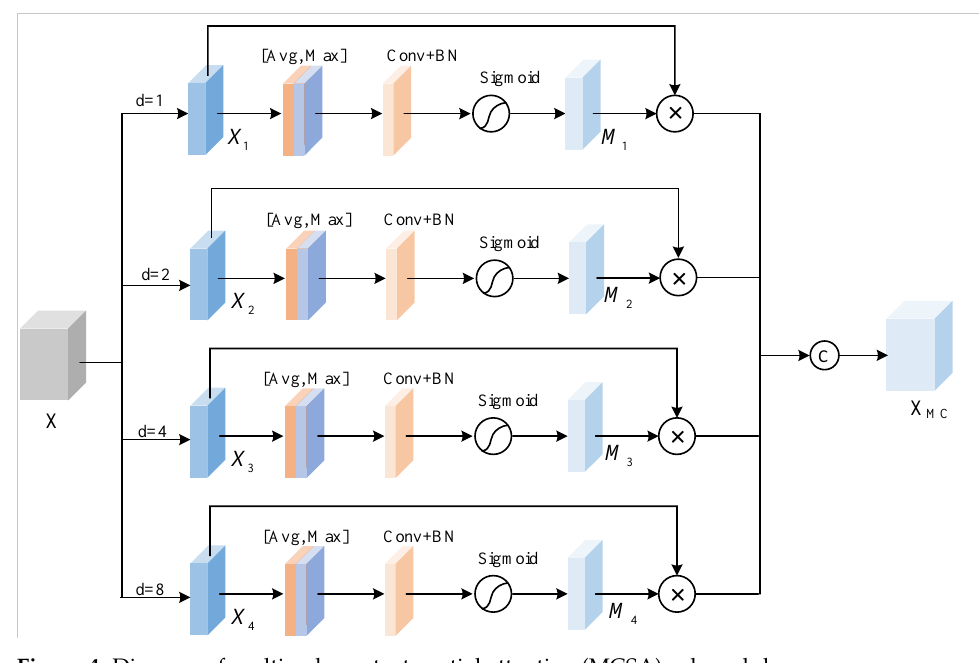
Figure 4. Diagram of multiscale context spatial attention (MCSA) submodule.